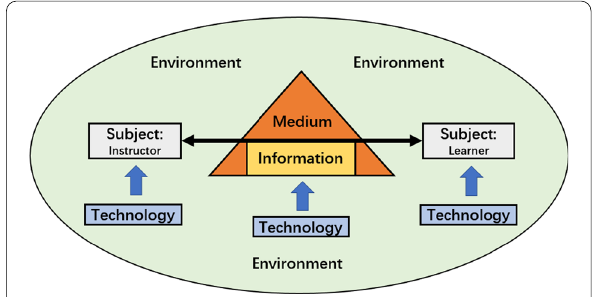
Fig. 2 The selection flowchart used based on PRISMA (Moher et al.,